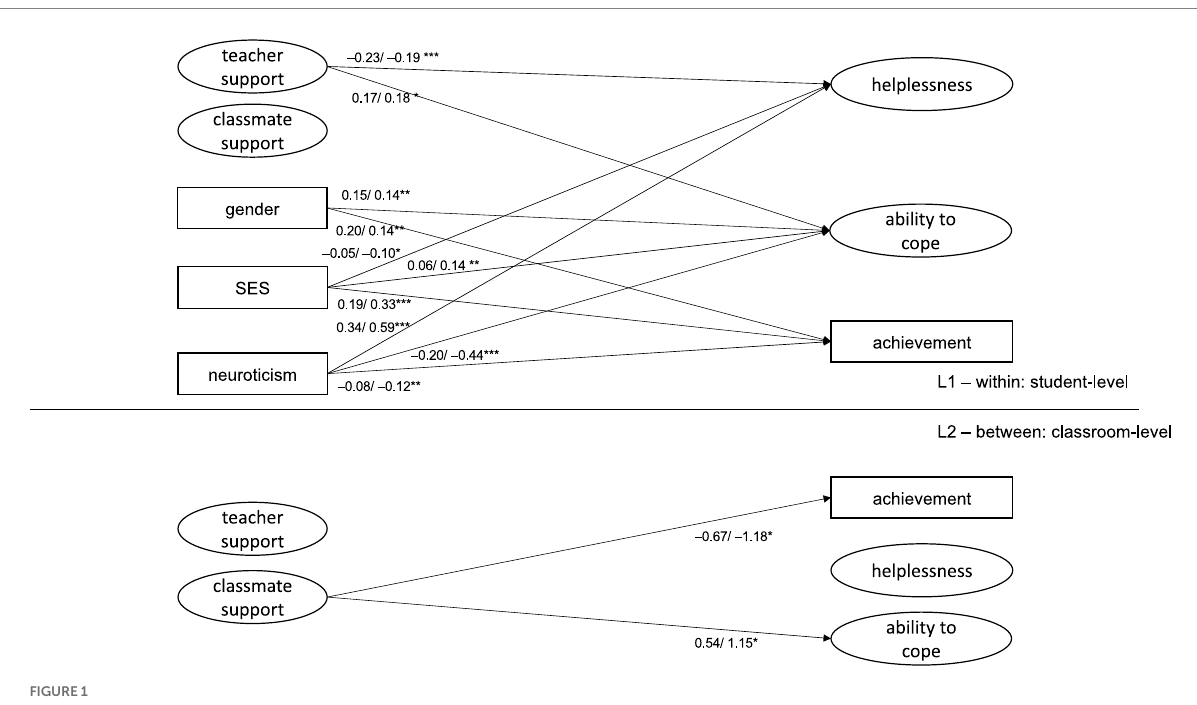
FIGURE 1 Final multilevel structural equation model. Note. Only significant paths are shown. Estimates are shown as first unstandardized and second as standardized estimates at * p < 0.05, ** p < 0.01, *** p < 0.001.